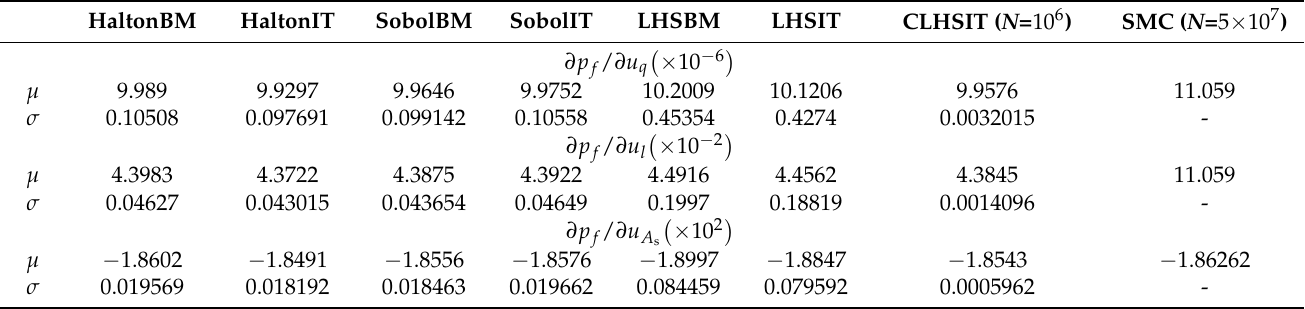
Table 7. Reliability and sensitivity results of different methods in Example 3 when N =